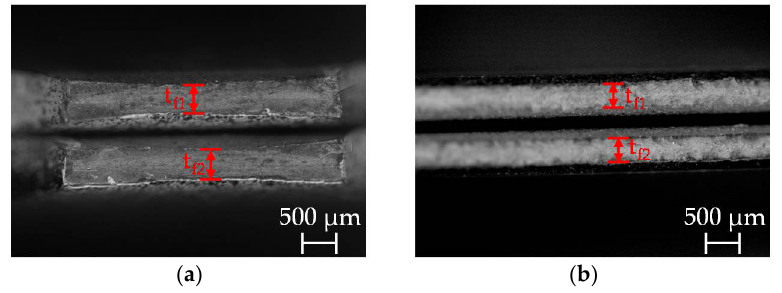
Figure 5. Measurement of fracture thickness: notched specimen ( a ); A 80mm specimen ( b ).